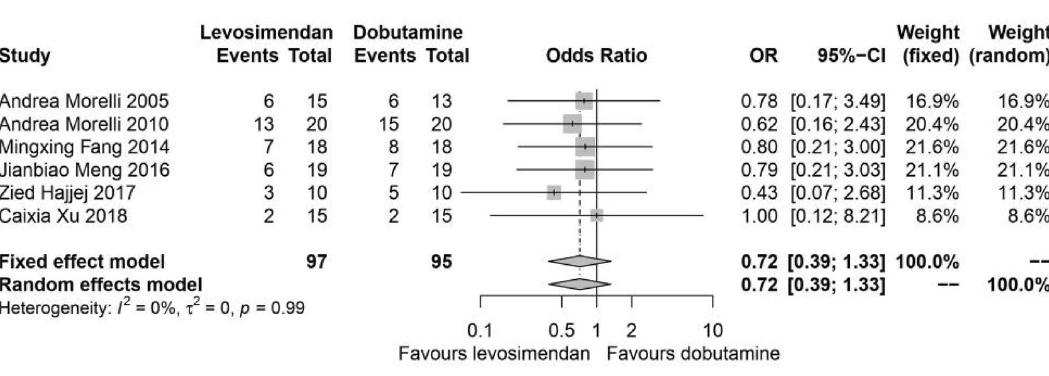
Figure 5. Mortality. OR odds ratio; CI confidence